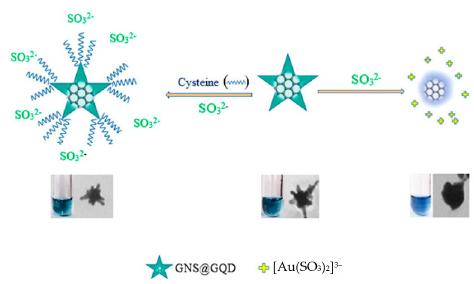
Figure 5. The etching reaction of AuNS@GQD with Na 2 SO 3 and detection of cysteine based on anti-etching effect. Reprinted with permission from Ref. [61]. Copyright 2021